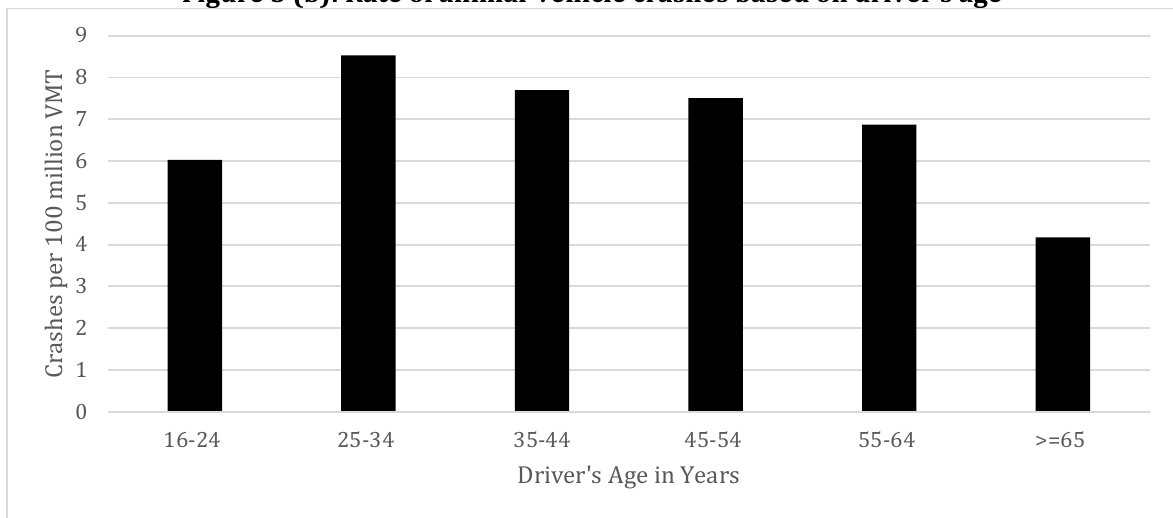
Figure 5 (b): Rate of animal-vehicle crashes based on driver’s